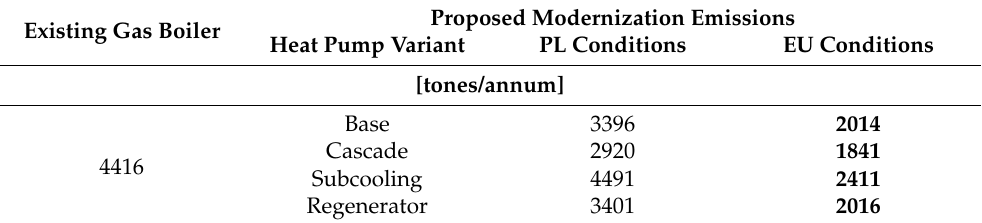
Table 5. Estimated CO 2 emissions of the designed heating